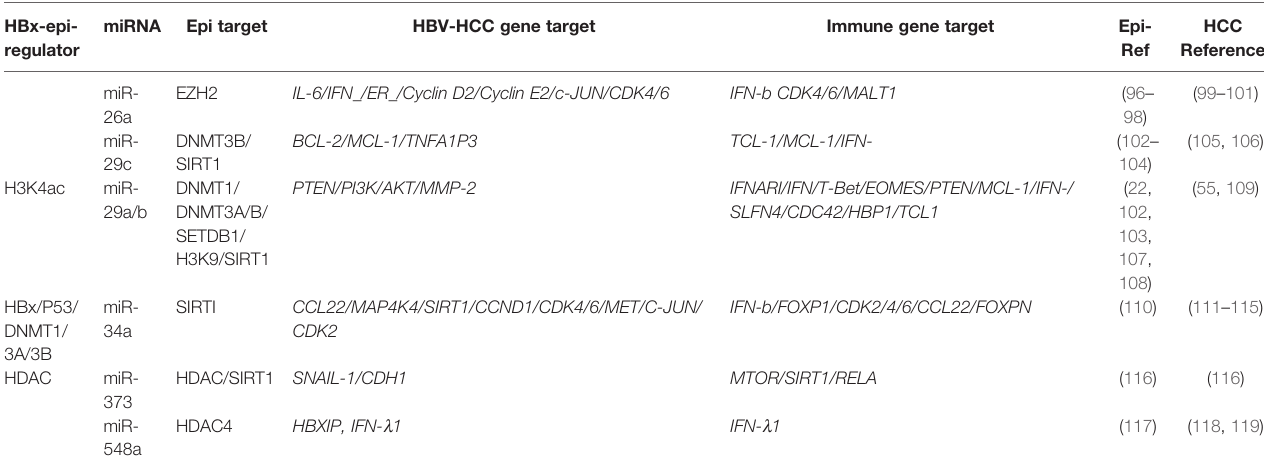
Column 1 indicates upstream epigenetic proteins that can in fl uence miRNA expression in column 2 (blue miRNA- downregulated and red miRNA-upregulated). Column 3 is downstream epigenetictargetsofdysregulatedmiRNA.Columns4and5arespeci fi cHBV-HCCandimmunegenetargets.Column6referstoepigeneticreferencesonly(column1and3)andcolumn7 to HBV-HCC and immune gene